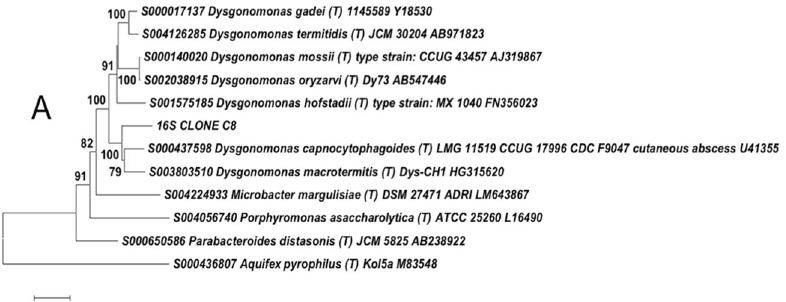
Figure 5. Neighbour-joining tree based on 16S rRNA gene sequences showing the relationship between cloned sequences from Phormia regina adults and sequences of other closely related bacterial species. Clone “16S CLONE C8” originated from sample (Fi12) that contained 92% of sequences assigned to the genus Dysgonomonas . Aquifex pyrophilus was used as an outgroup. The sequences were aligned using the ClustalW algorithm. Bootstrap values based on 500 replications, are given at the branching nodes. Bar represents 0.05 substitutions per nucleotide